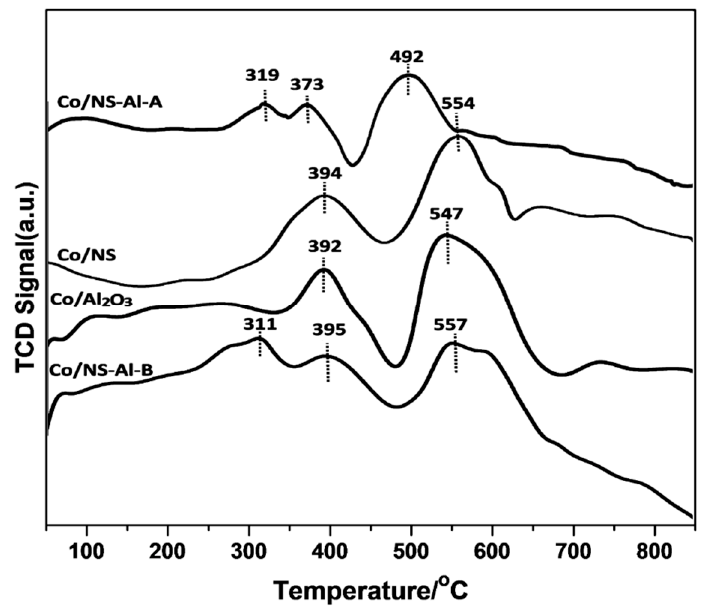
Figure 6. H 2 -TPR profiles for the Co/NS-Al 2 O 3 , Co/NS, Co/Al-A and Co/Al-B catalysts.